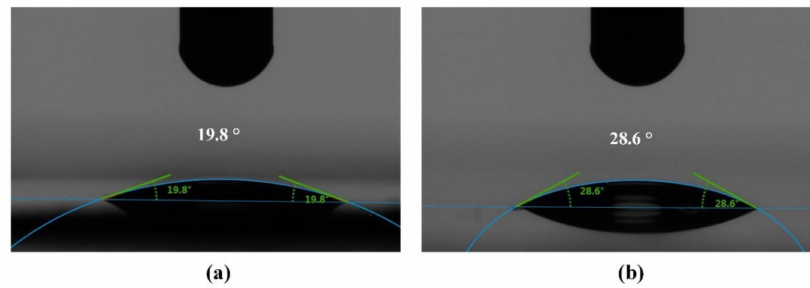
Figure 4. The contact angle between the resin and ( a ) mold ( b ) substrate.